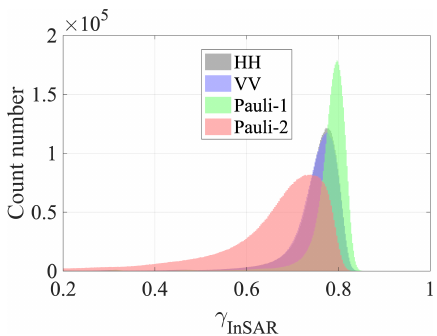
Figure 4. Magnitude of the interferometric coherence | ˜ γ InSAR | .